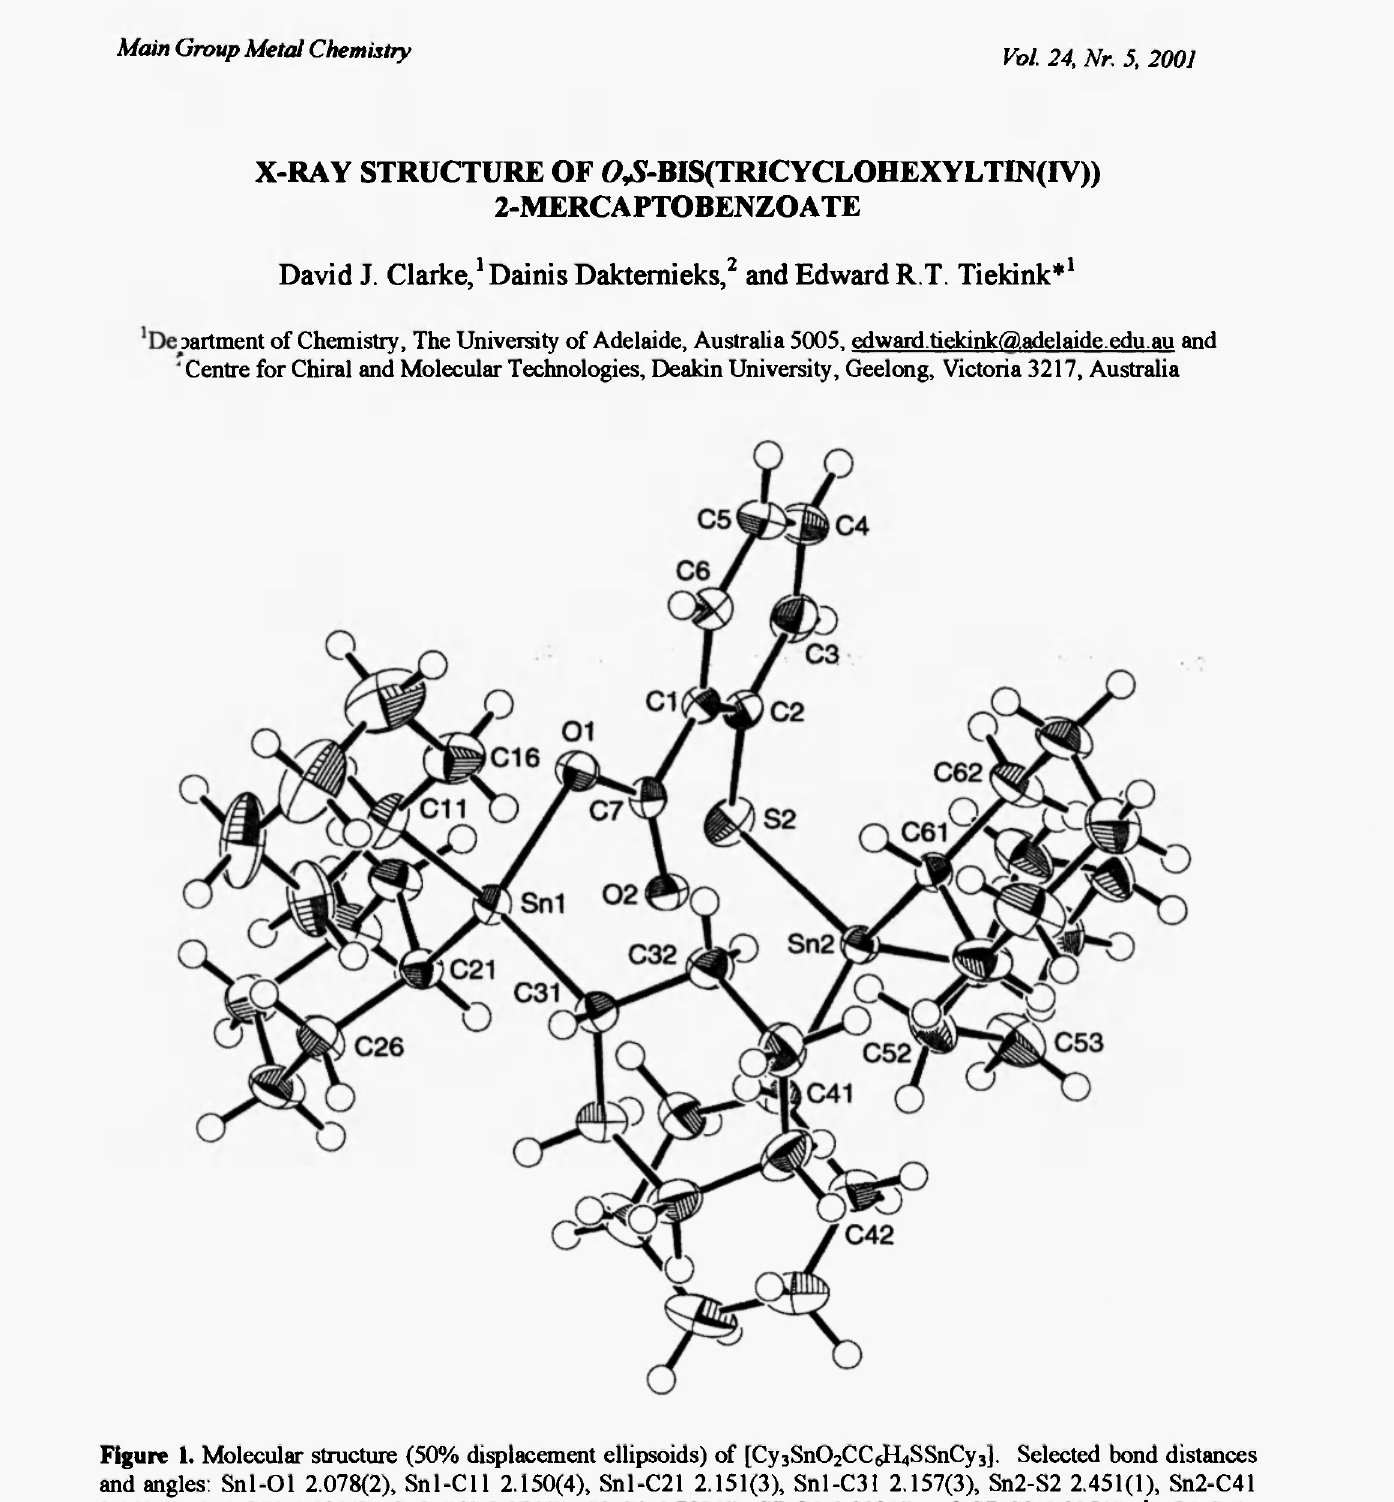
Sn0 CC H SSnCy3]. Selected bond distances 3 2 6 4